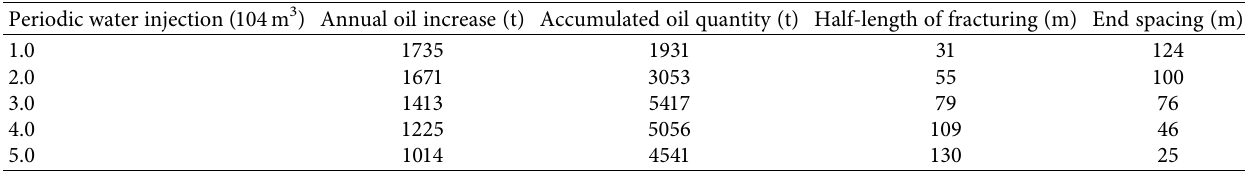
Figure 4: Schematic diagram of the gap between the pressure fracture and the pressure drive fracture. Table 4: Comparative data table of pressure drive effect under water injection rate in different periods.